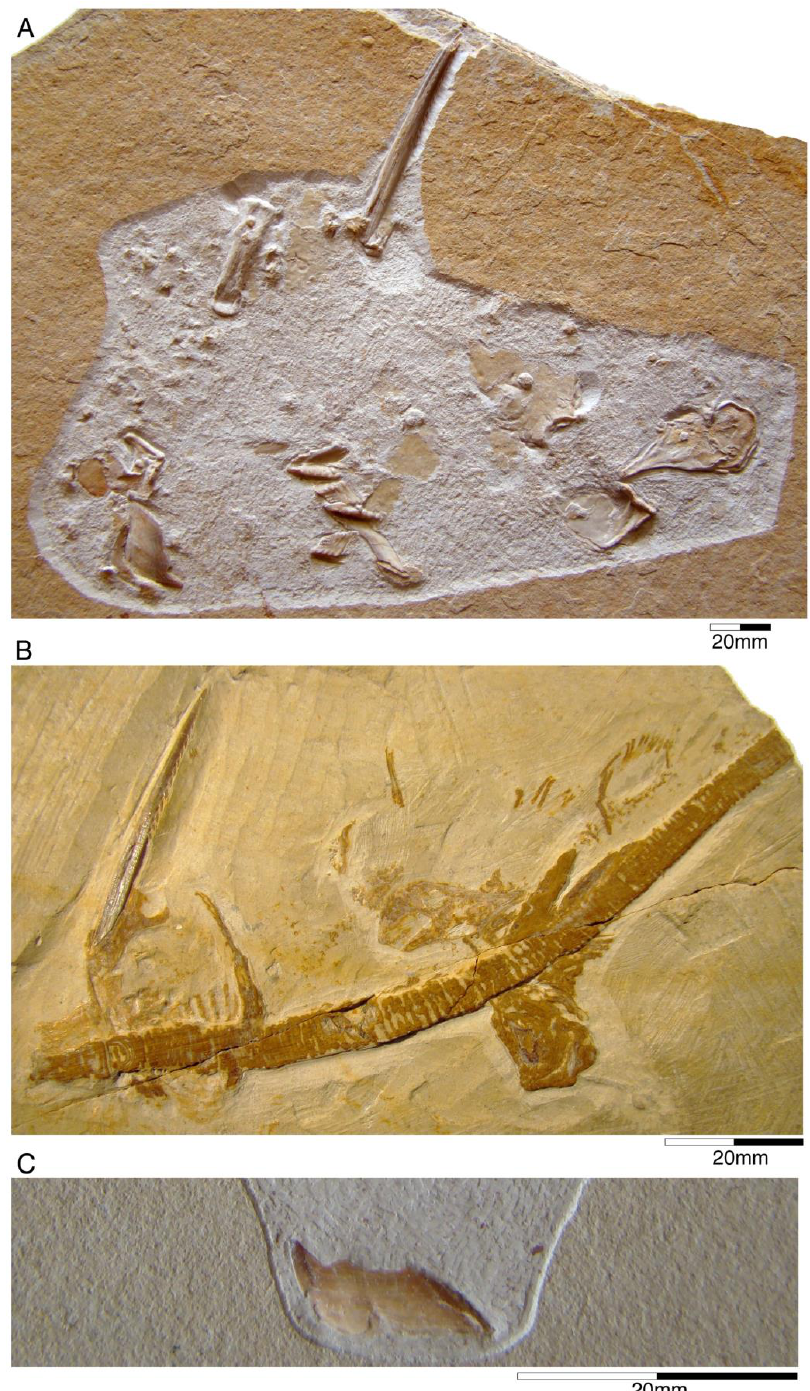
Figure 8. Specimens of † Elasmodectes avitus (von Meyer, 1862 [120]) from the upper Kimmerid- gian (Upper Jurassic) of Nusplingen. ( A ) Disarticulated male specimen (SMNS 80142/16) of the quarry of Egesheim auf dem Westerberg displaying cranial remains including the frontal clasper and dorsal fin spine. This specimen was recovered in 1993 and figured by Duffin [78] (figure 4). ( B ) Partially preserved skeleton (SMNS 51564) displaying part of the vertebral column, the dorsal fins including the fin spine and parts of the pelvic girdle. The specimen was figured by Schweizer [66] (figure 14, pl. 12, figures 1–4). ( C ) Strongly disarticulated specimen (SMNS 86901/35) of the quarry of the Gesellschaft für Naturkunde Württemberg) displaying the left mandibular tooth